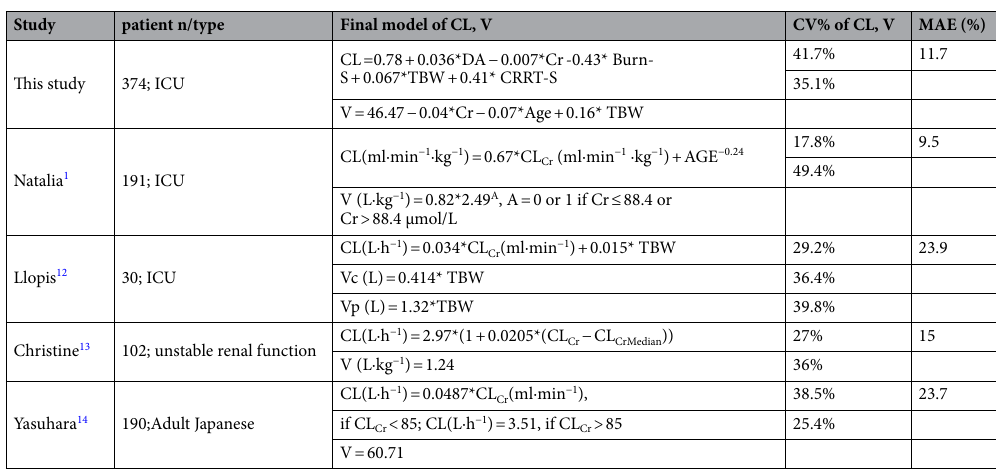
Table 7. Vancomycin PPK model studies in adult patients by the nonlinear mixed-effects modeling method. Vc central compartment volume; Vp peripheral compartment volume; %CV as coefficient of variation; MAE as mean absolute prediction